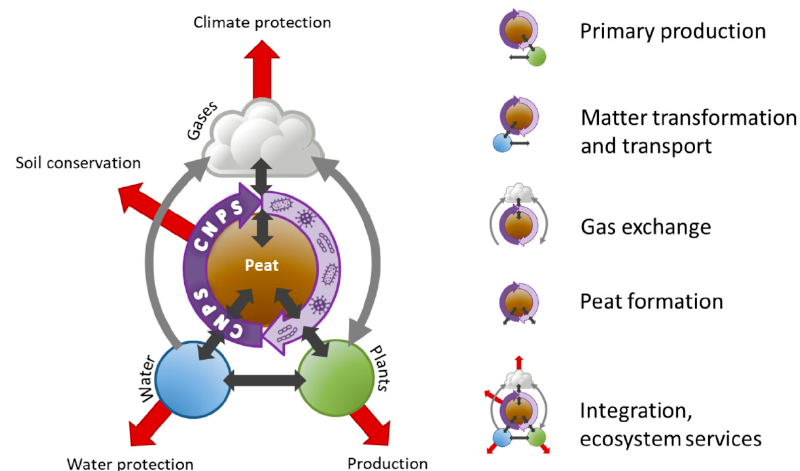
Figure 1. Interactions of a peatland ecosystem. Here, primary production addresses the production of plant biomass. The production function is of particular importance for paludicultural systems. Peat formation means the potential re-growth of peat. Matter transformation and transport deals with nutrient cycling concerning the elements carbon (C), nitrogen (N), phosphorus (P) and sulfur (S). Gas exchange looks into the production and exchange of the greenhouse gases carbon dioxide, methane and nitrous oxide. The thin arrows represent the integration between the research areas, the red arrows represent ecosystem services.